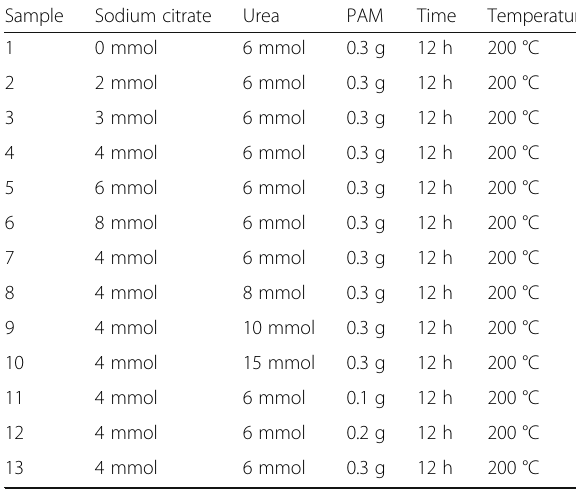
Table 1 The detailed experimental conditions for the preparation of superparamagnetic Fe 3 O 4 hollow microspheres